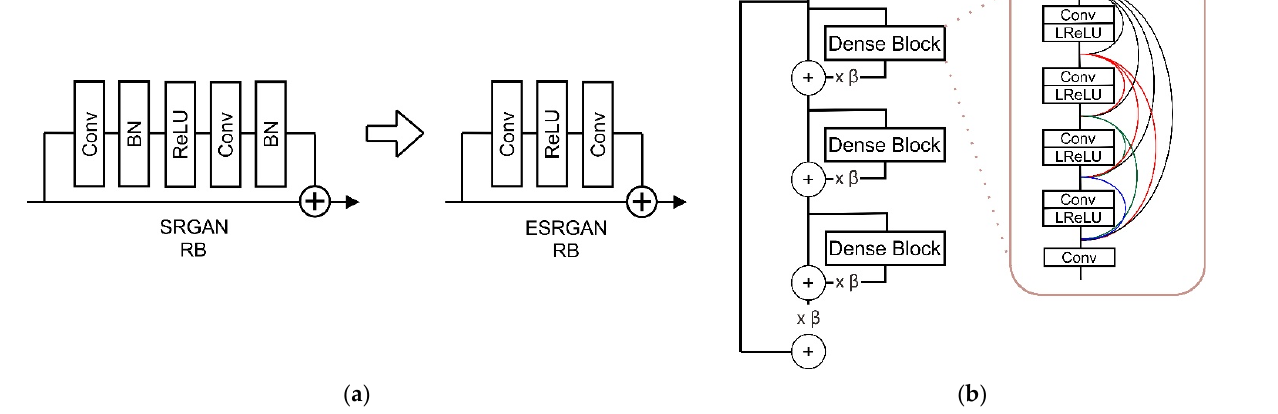
Figure 2. ( a ) ESRGAN improves the SRGAN with removing BN in the residual block. ( b ) The Residual in residual dense block (RRDB) and residual scaling parameter (cid:4666)β(cid:4667) used at the SRGAN structure. Removing batch normalization [49] can reduce memory usage by up to four times, achieve better performance than the standard ResNet structure model, and serve as the best simple strategy for sharpening and deblurring images [51]. In the generator structure, ESRGAN keeps the high ‐ level SRGAN architecture. The main difference is that each block contains some convolution layer and activation functions using Leaky Rectified Linear Unit (LReLU) to prevent dead nodes [9]. Improvement can be seen by scaling down the residuals by multiplying a constant between 0 and 1 before adding them to the main path to prevent instability and using initialization when training has a slight variance.